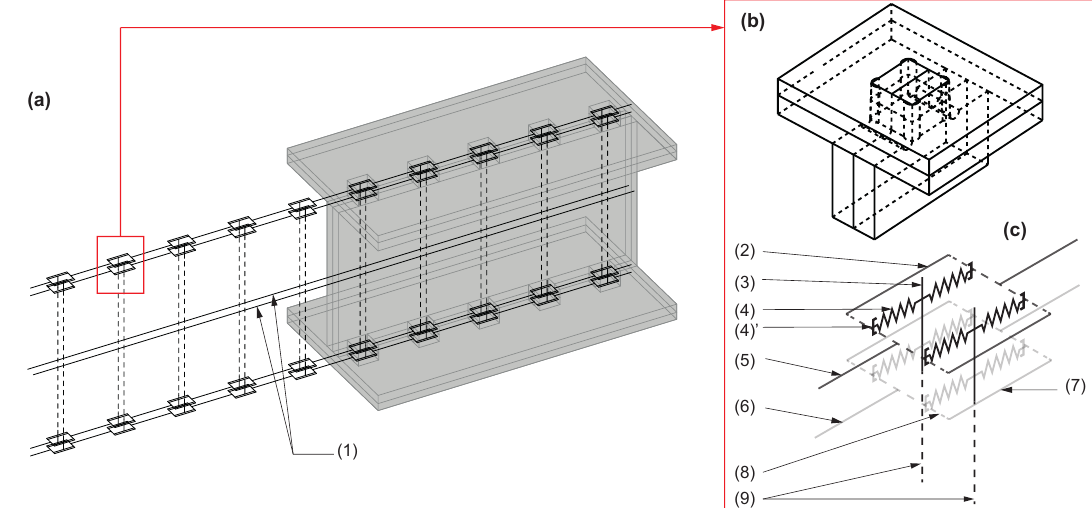
Figure 4. ( a ) Representation of the proposed calculation model (black lines) for the I-beam using TT connections (3D grey solid). ( b ) Axonometry of one TT joint. ( c ) Modeling of this joint with beam elements and